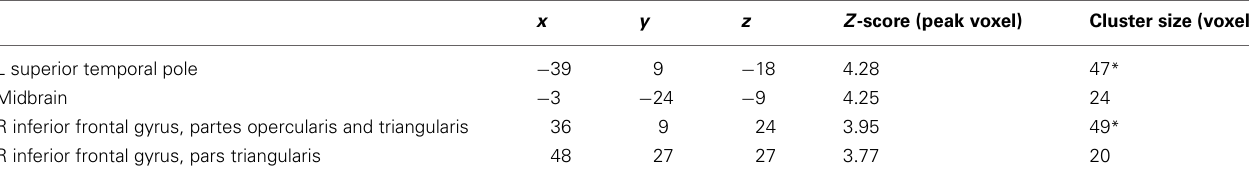
Table 4 | Brain areas with training (NECT vs. SUDOKU) specific associations between training-induced changes in the behavioral sensitivity to non-verbal emotional cues as measured by response times and the respective cerebral activation patterns (contrast of interest: T0 [ EMO − NEU ] − T1 [ EMO − NEU ] ).